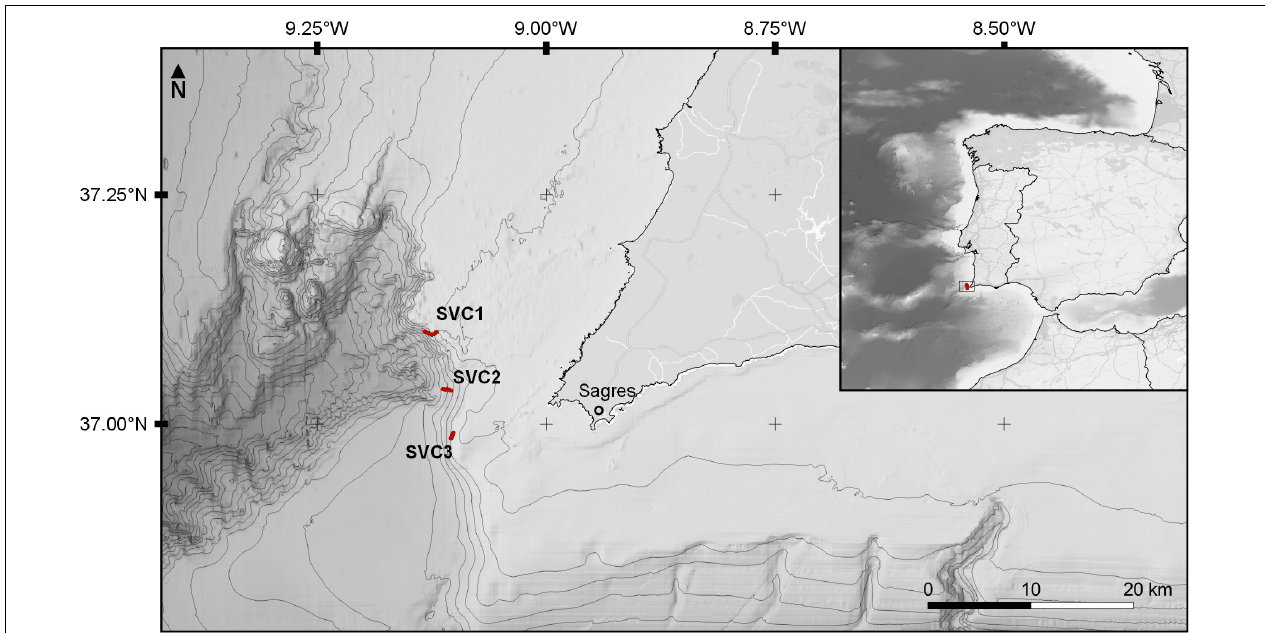
FIGURE 1 | The location of the study area at the head of the São Vicente Submarine Canyon in the southwest of Portugal. The large map shows the location of the three transects located around the head of the canyon (SVC1, SVC2 and SVC3 respectively, from north to south). The map in the right corner shows the location on the Iberian Atlantic coast. Bathymetry lines are drawn for every 200 m; data was obtained from EMODnet